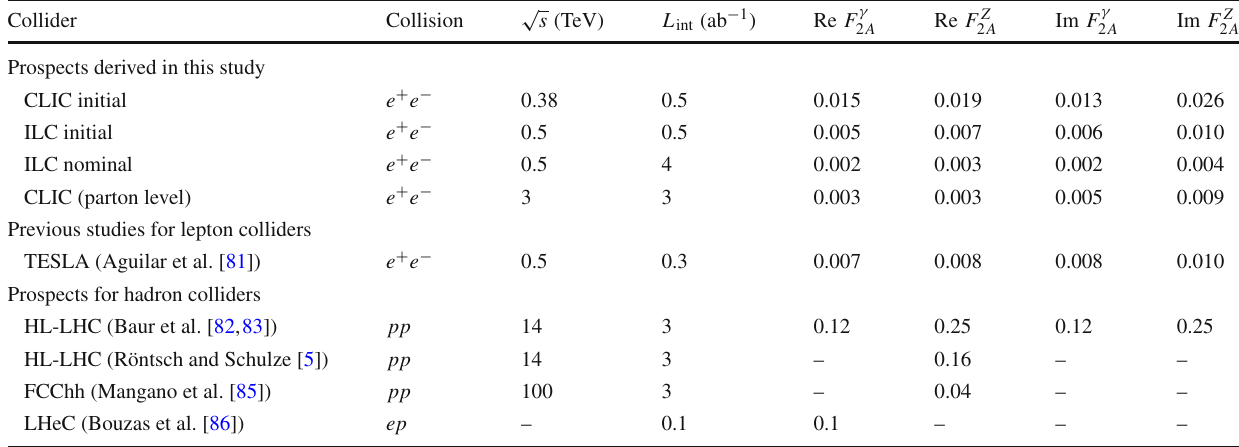
Table 8 The expected standard deviations (68% C.L. limits) of CP- violating form factors derived from the statistical precisions on the observables O Re , Im